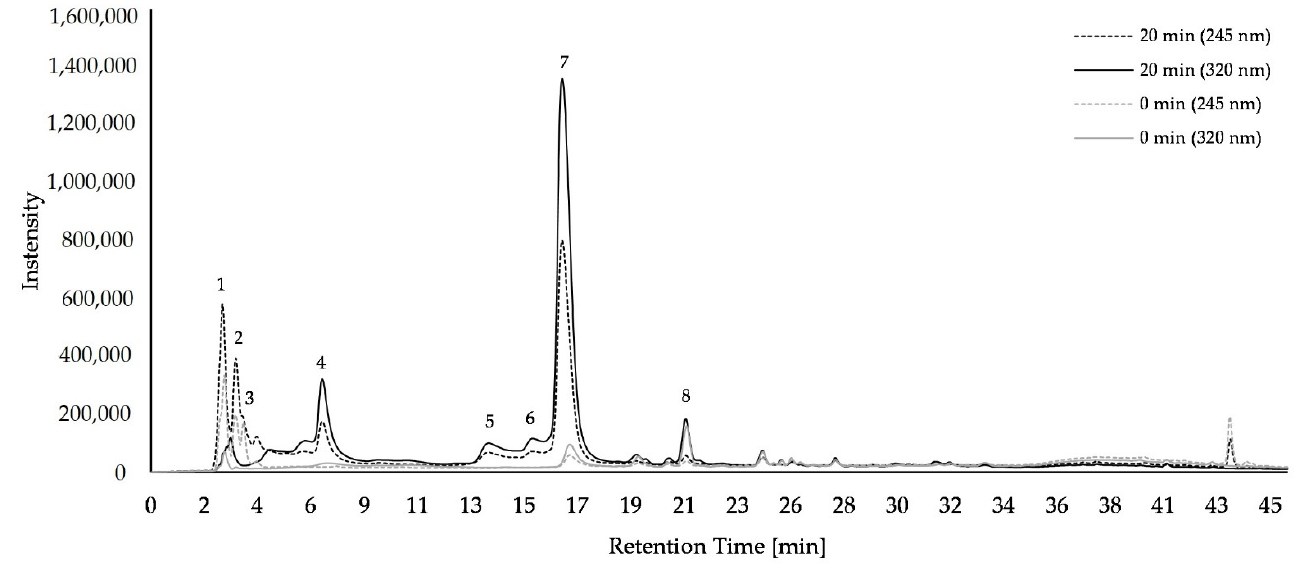
Figure 1. Chromatogram of ascorbic acid and phenolic compounds in Urtica dioica L. samples detected by HPLC-DAD after freeze-drying without storage at wavelengths of 245 nm (dotted line) and 320 nm (solid line). Cooking time of 0 min (gray) and 20 min (black); 1–3: ascorbic acid and its derivatives; 4: coumaroylglucaric acid isomer 1; 5: coumaroylglucaric acid isomer 2; 6: di-caffeoylquinic acid; 7: 5- caffeoylquinic acid; 8: caffeoylmalic acid.